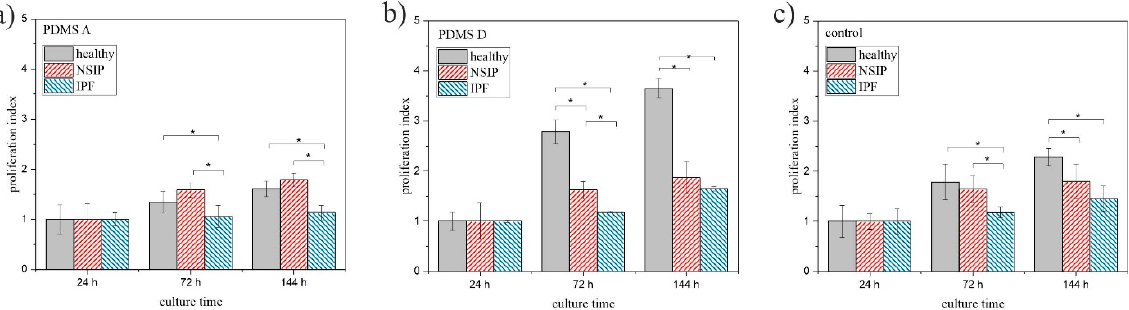
Figure 4. Proliferation index determined for healthy (gray), NSIP- (red), and IPF-derived (blue) fibroblasts cultured on PMDS A ( a ), PDMS D ( b ), and control (glass, ( c )). Statistical significance was achieved for p < 0.01 (*).